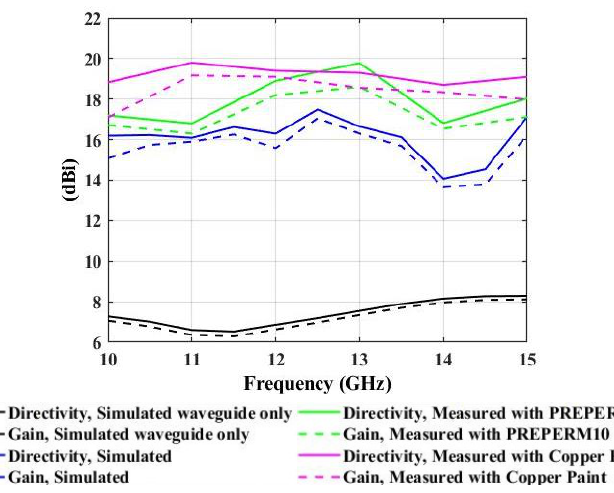
Figure 12. Simulated and measured directivity and gain as observed with the placement of the proposed miniaturized wideband prototype.